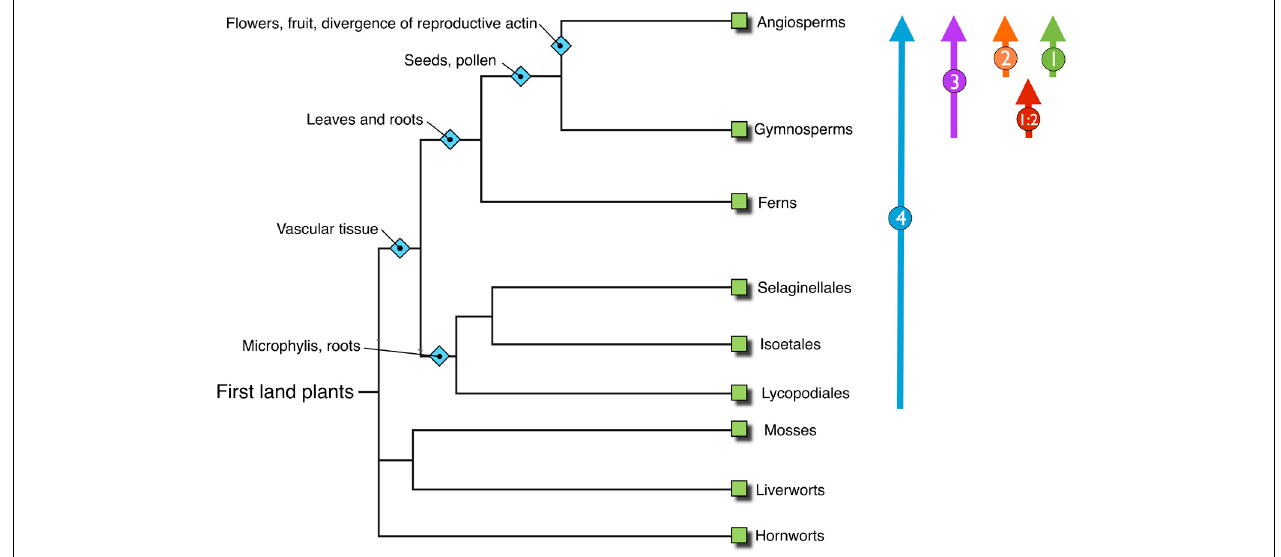
filaments colocalize with the vacuole membrane and